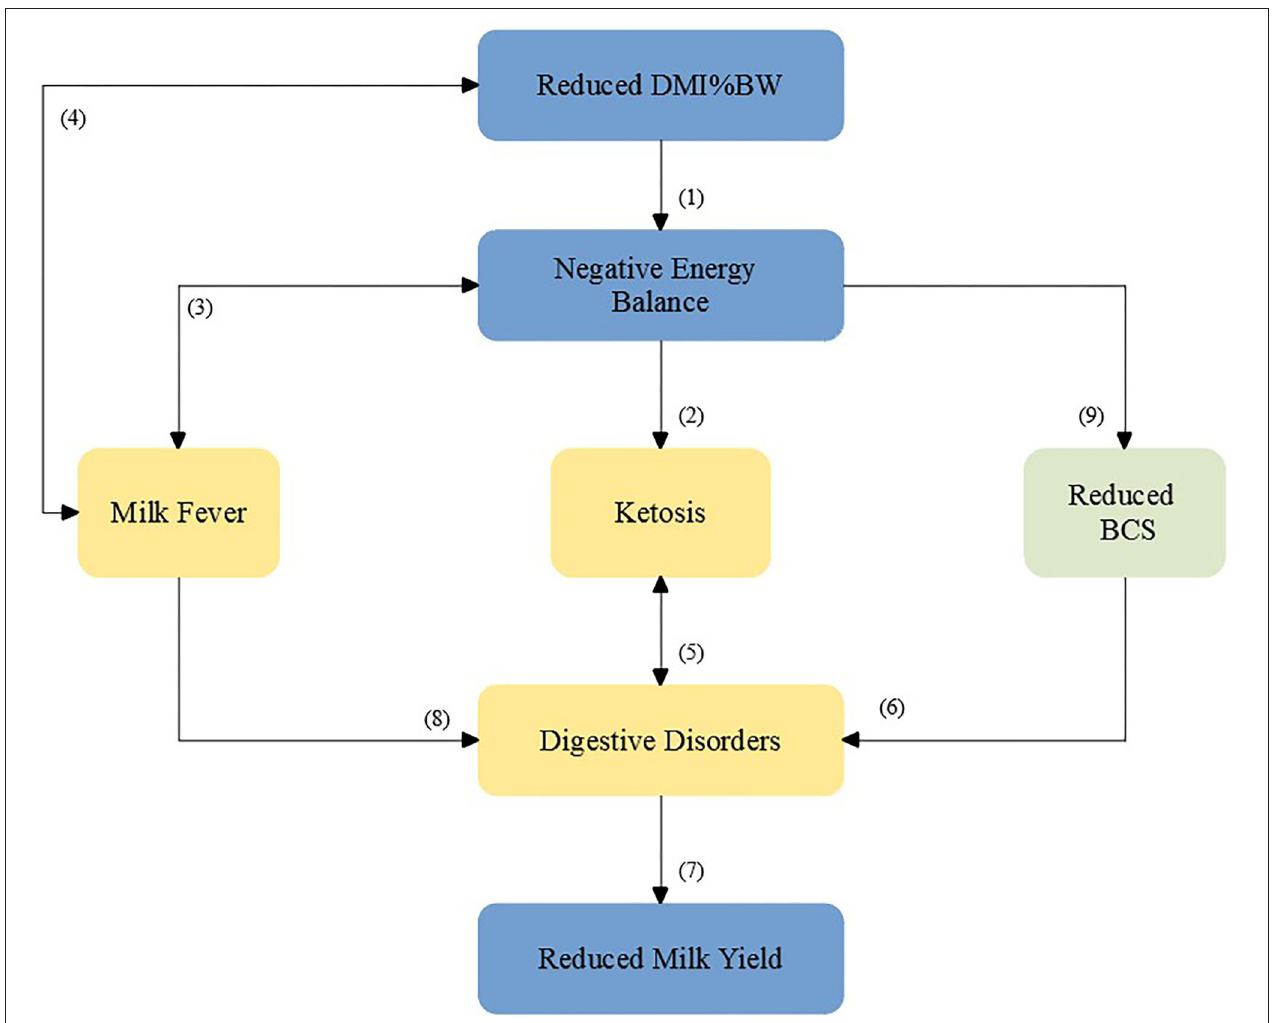
FIGURE 1 | Causal diagram showing the relationship of dry matter as percentage of body weight (DMI%BW) and energy balance with digestive disorders and its consequences. Based on the work of the following: (1) Hammon et al. ( 19); (2) Ospina et al. (17); (3) Martinez et al. (20); (4) Martinez et al. (21); (5) Raboisson et al.